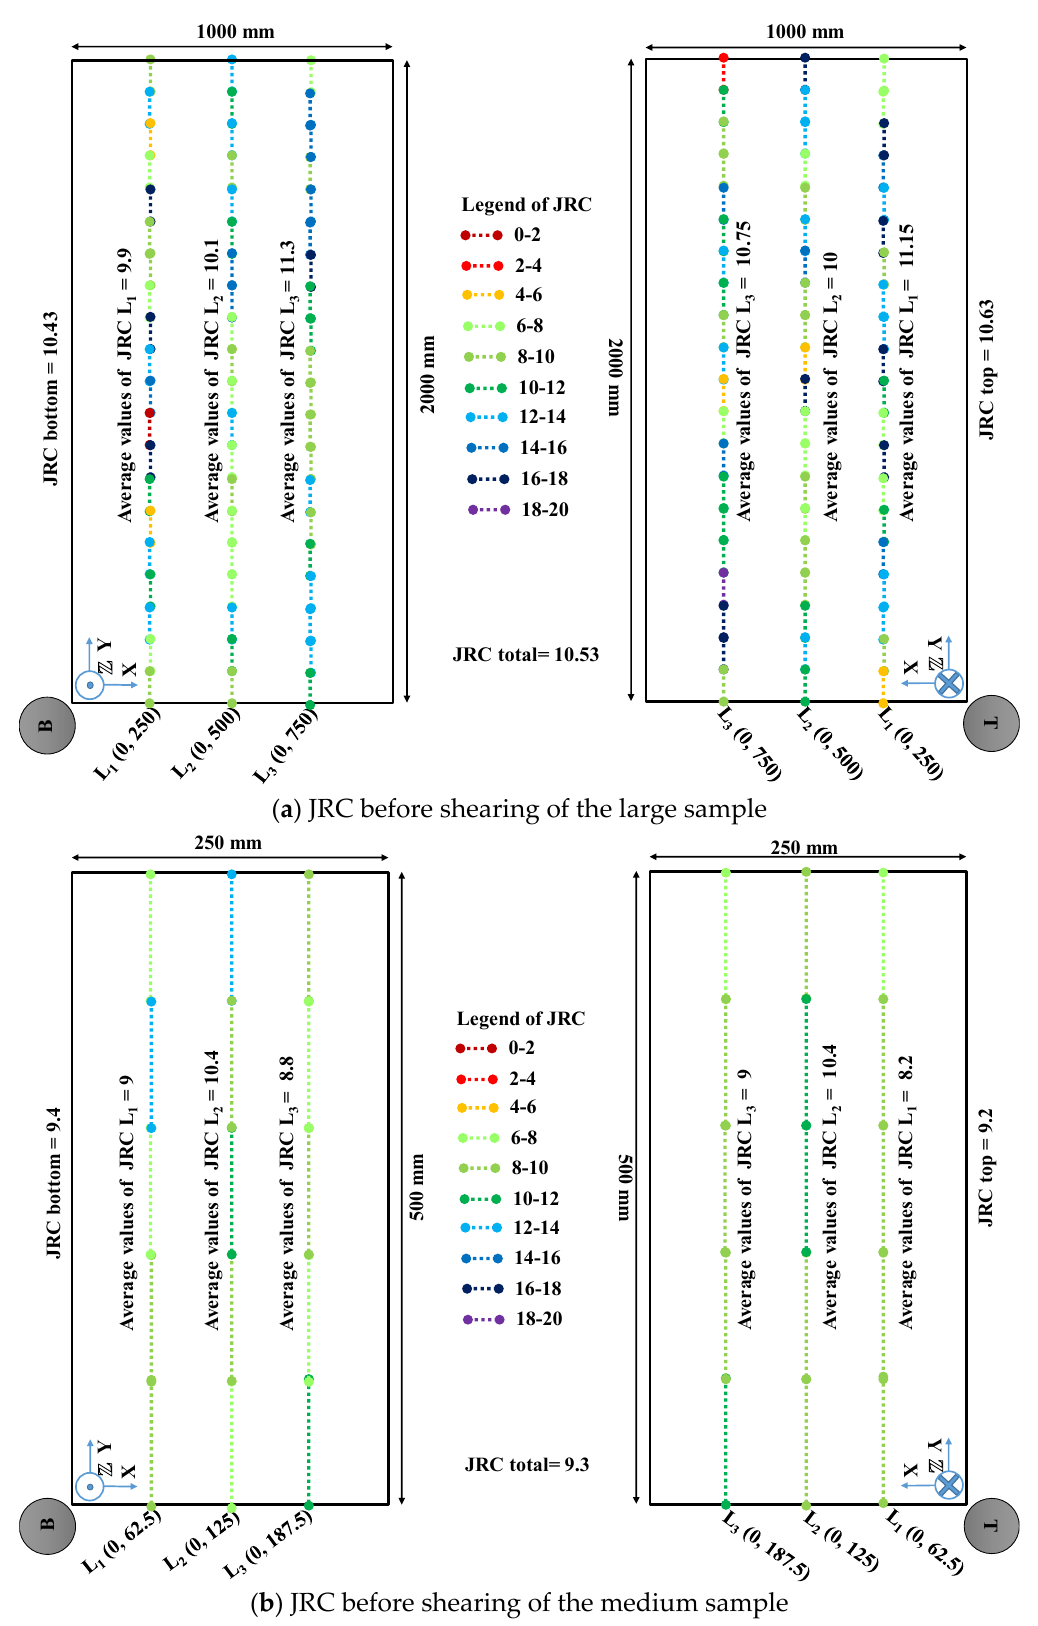
Figure 9. The JRC profilometer results of the slabs; pre-shearing of the large sample ( a ), pre-shearing of the medium sample ( b ).